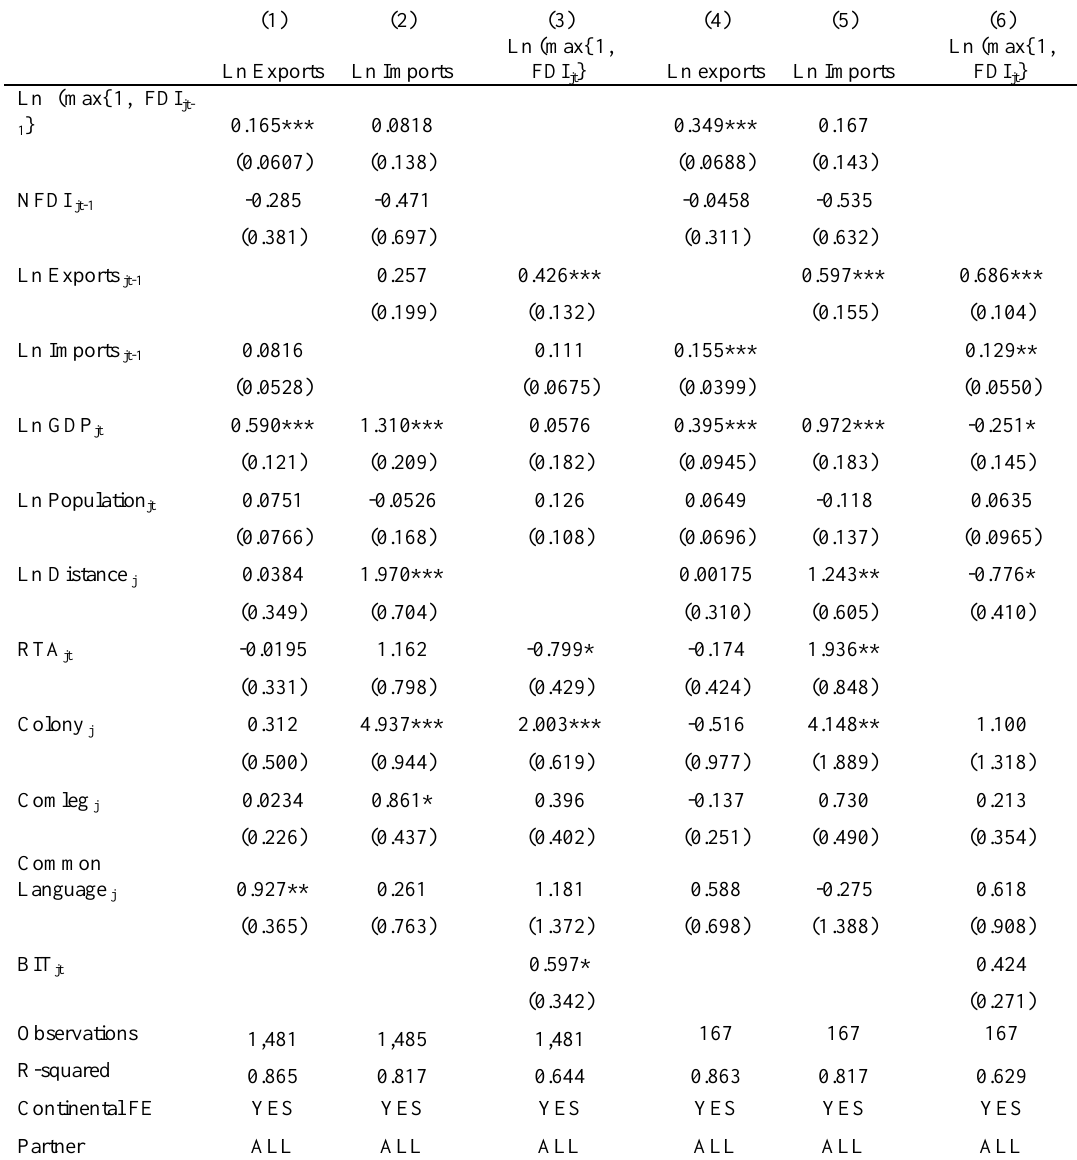
Table 5 . Main Results with Between Estimator (1)–(3) and Between-SUR Estimator (4) to